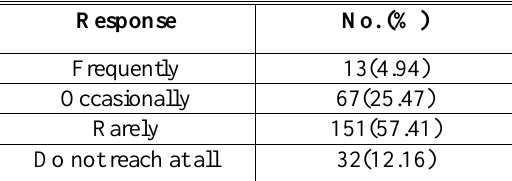
Table 7. Accessibility of continuous pharmacist education programs for Iraqi pharmacists (n=263).